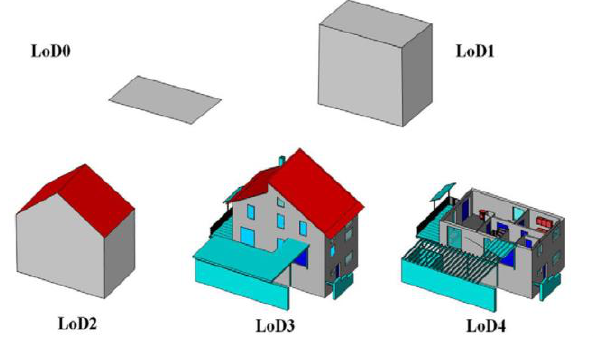
Figure 1 – Representation of different level of details (Gröger & Plümer